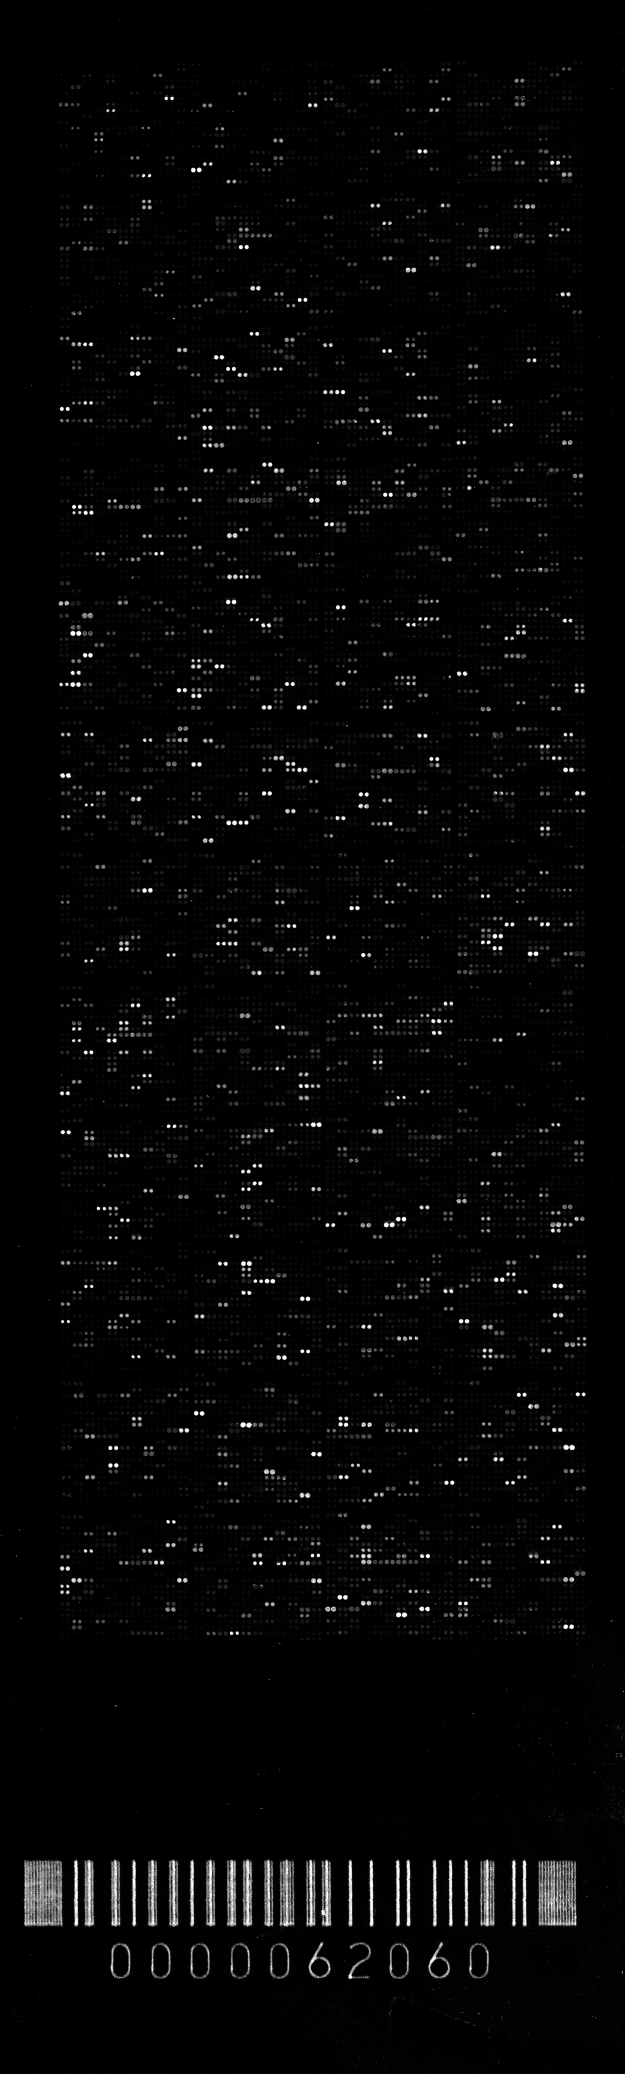
High Resolution Array Image. Experimental assay with G4-3, profiled at 25 μM.